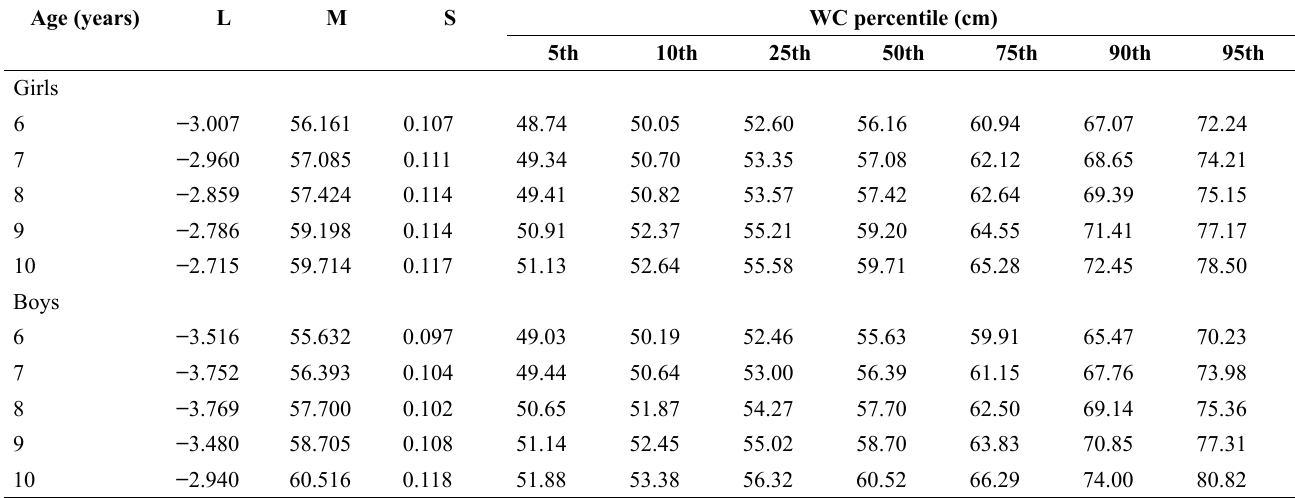
Table3: Smoothed age-specific percentile values of waist circumference in Brazilian girls and boys Age